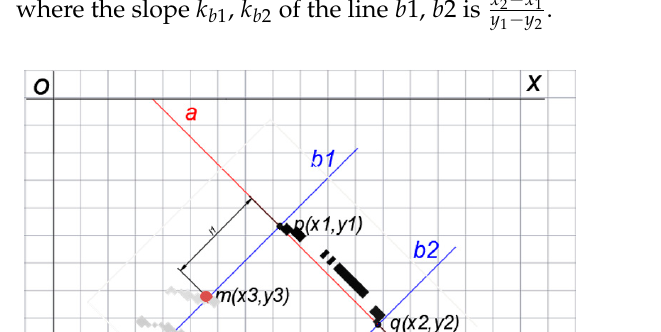
Figure 12. ROS Autonomous Navigation Vehicle. Table 1. Specific parameters of the experiment.